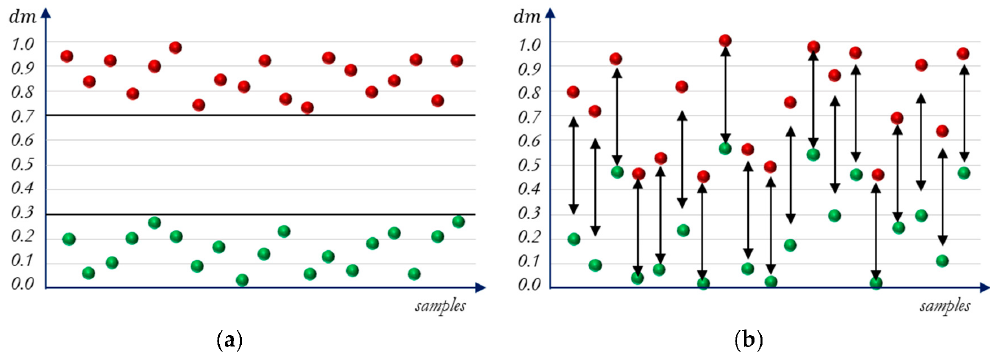
Figure 6. Scheme of the constraints imposed by the Double-Margin-Contrastive loss ( a ) and the Triplet loss ( b ) over the data in the metric distance space. Points in green renders the distance resulting of comparing the images of a positive pair, and points in red, a negative pair.